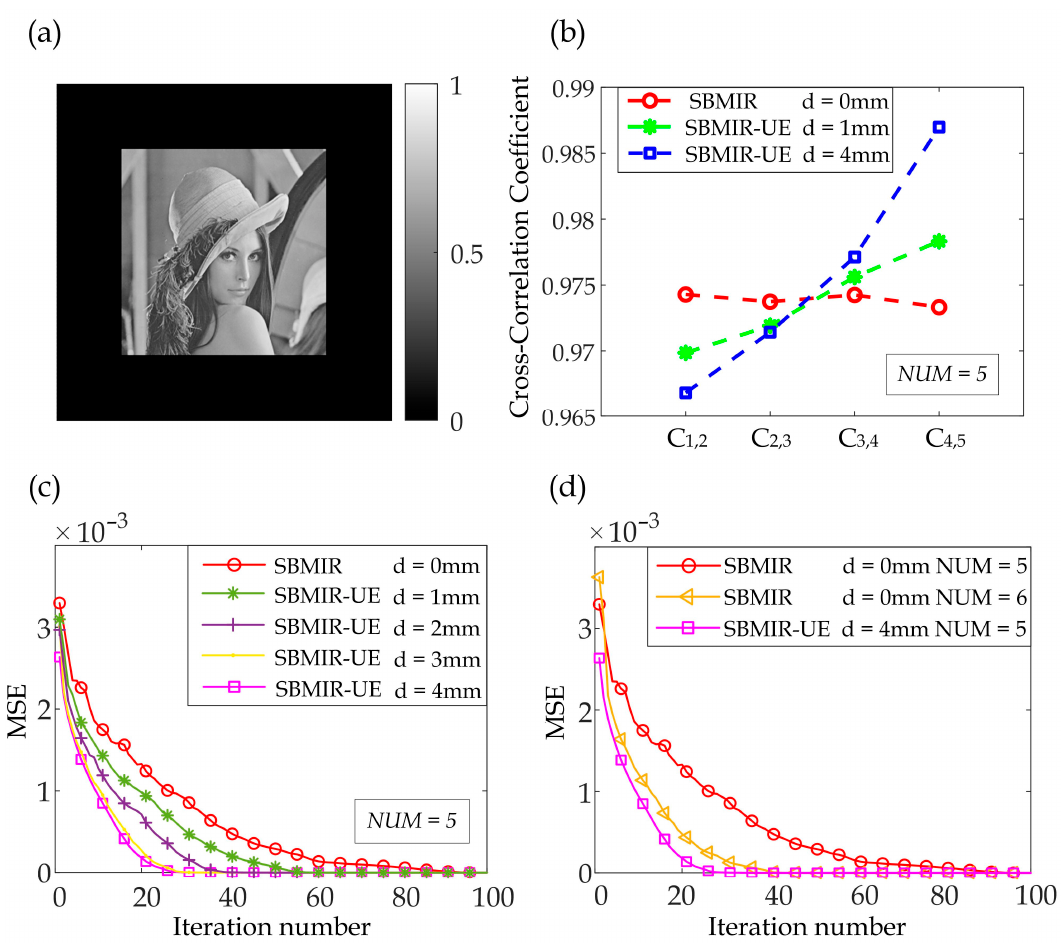
Figure 2. Numerical simulation: ( a ) The ground truth of the simulated object; ( b ) The cross-correlation coefficient between the two adjacent planes using SBMIR and SBMIR-UE, respectively; ( c ) Plots of mean square error (MSE) of SBMIR and SBMIR-UE with different interval spaces. ( d ) Plots of mean square error of SBMIR using five and six diffraction patterns, SBMIR-UE using five diffraction patterns with interval space of the adjacent planes ∆ z = 4